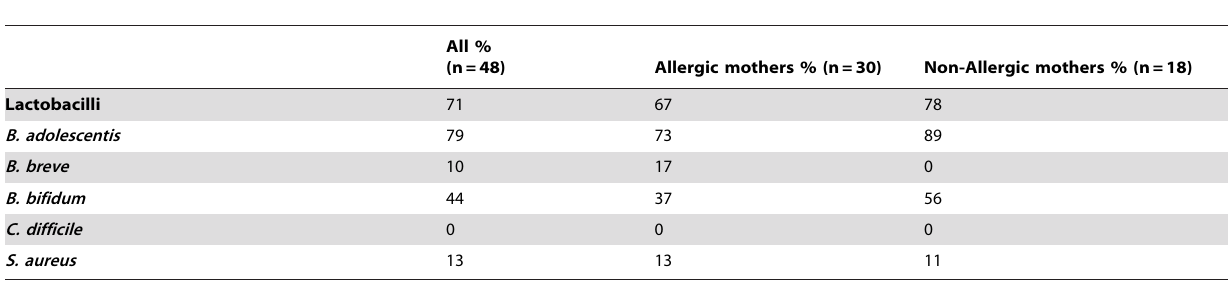
Table 3. Frequencies of species investigated among allergic and non-allergic mothers.